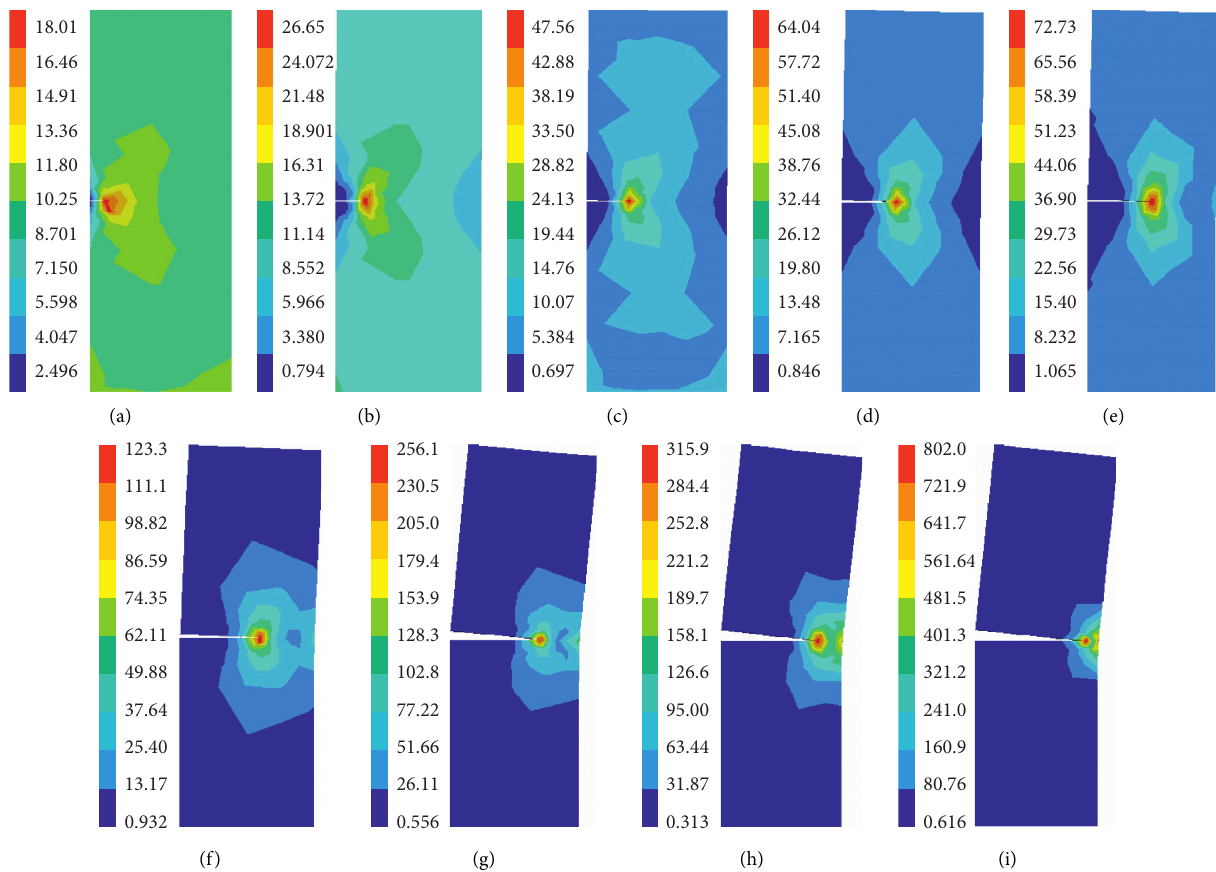
Figure 9: Mises stress distributions of plate with different crack lengths: (a) 1 mm, (b) 2mm, (c) 3 mm, (d) 4mm, (e) 5mm, (f) 6mm, (g) 7mm, (h) 8mm, and (i)